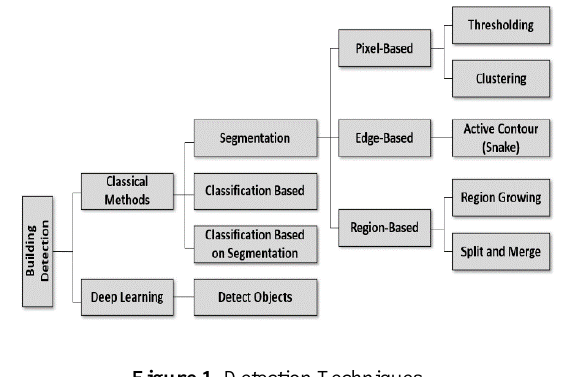
Figure 1 . Detection